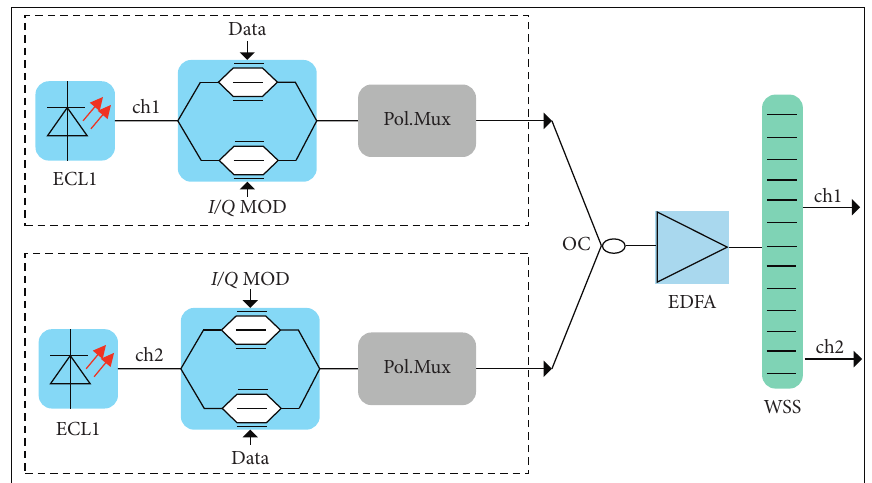
Figure 18: Schematic diagram of antenna polarization